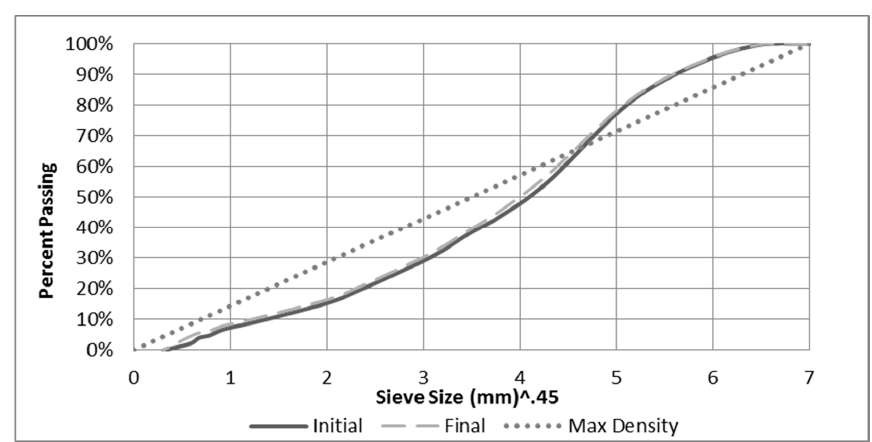
Figure 3. Average gradation changes of high-quality aggregate samples. Forests 2020 , 11 , x FOR PEER REVIEW